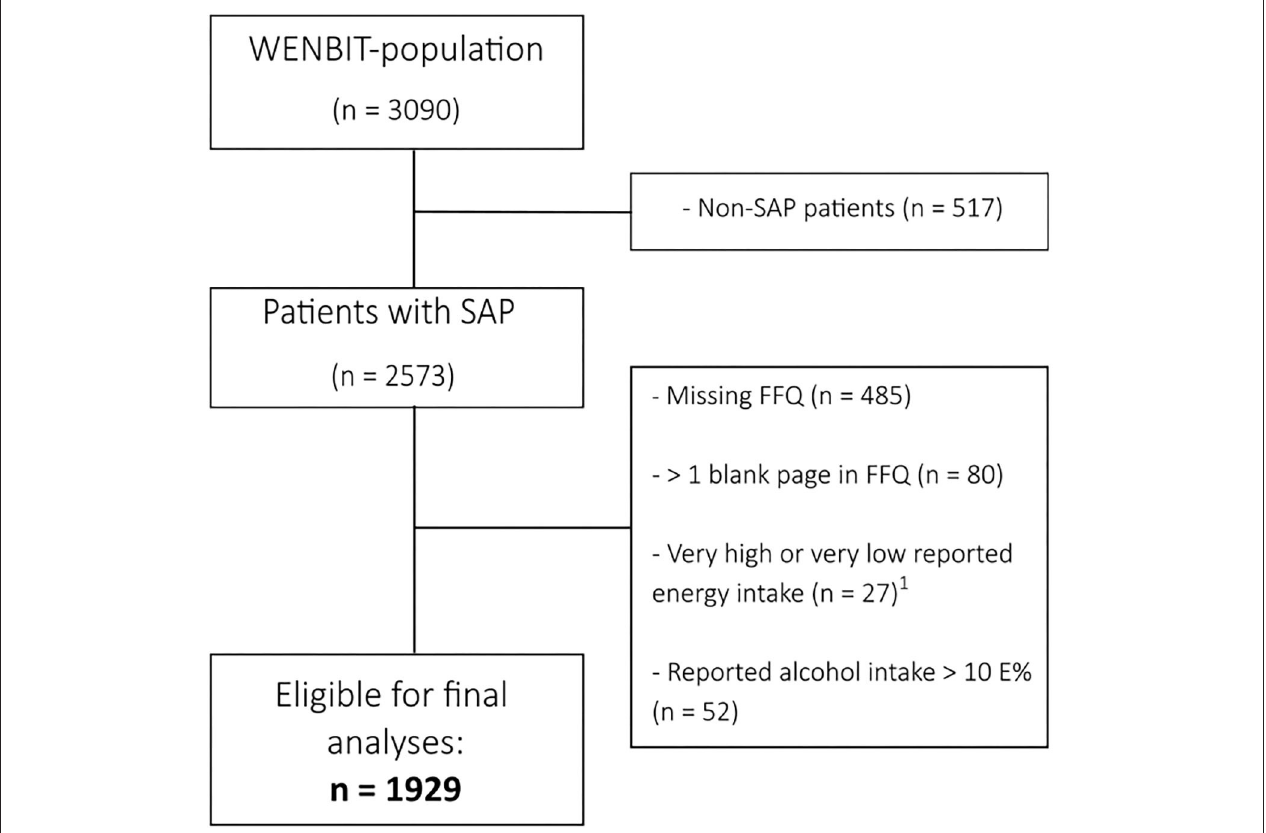
FIGURE 1 | Flowchart illustrating the selection of patients from the WENBIT-cohort. 1 Self-reported energy intake < 717 kcal or > 3,585 kcal ( < 3,000 or > 15,000 kJ) for females, and < 789 or > 4,183 kcal ( < 3,300 or > 17,500 kJ) for males. FFQ, Food frequency questionnaire; SAP, Stable angina pectoris; WENBIT, Western Norway B-vitamin Intervention